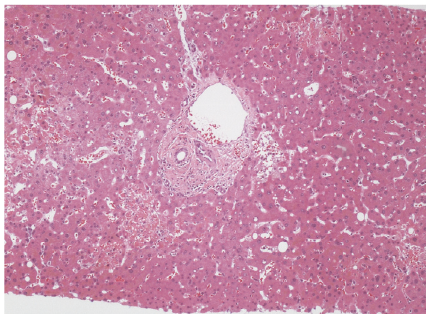
Figure 8: Areas of necrosis abutting portal triad with chronic min- imal inflammation; no significant steatosis seen and no periportal fibrosis or vasculitis